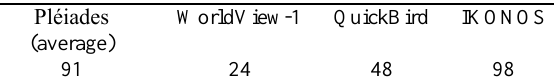
Table 6. SNR for panchromatic images with 16 bit